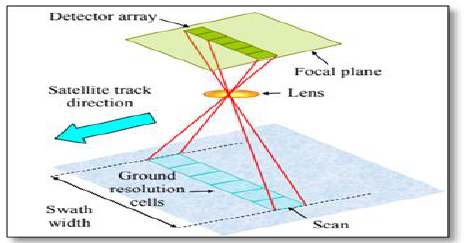
Figure 7. Push Broom camera a Long Track Scan Nevertheless, the Dwell time depends on some factors, such as: satellite speed, width of scan line, time per scan line and time per pixel. Period of time that required be estimated in case of maneuver the VRSS-1 and VRSS-2 to scan areas affected for disasters through different scan